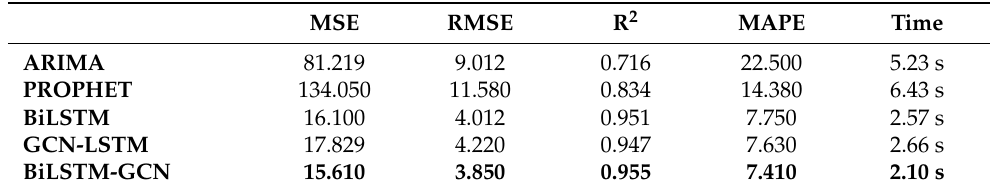
Table 4. Model Performance in terms of MSE, RMSE, R 2 , MAPE and Time. The best values for each metric are in bold.